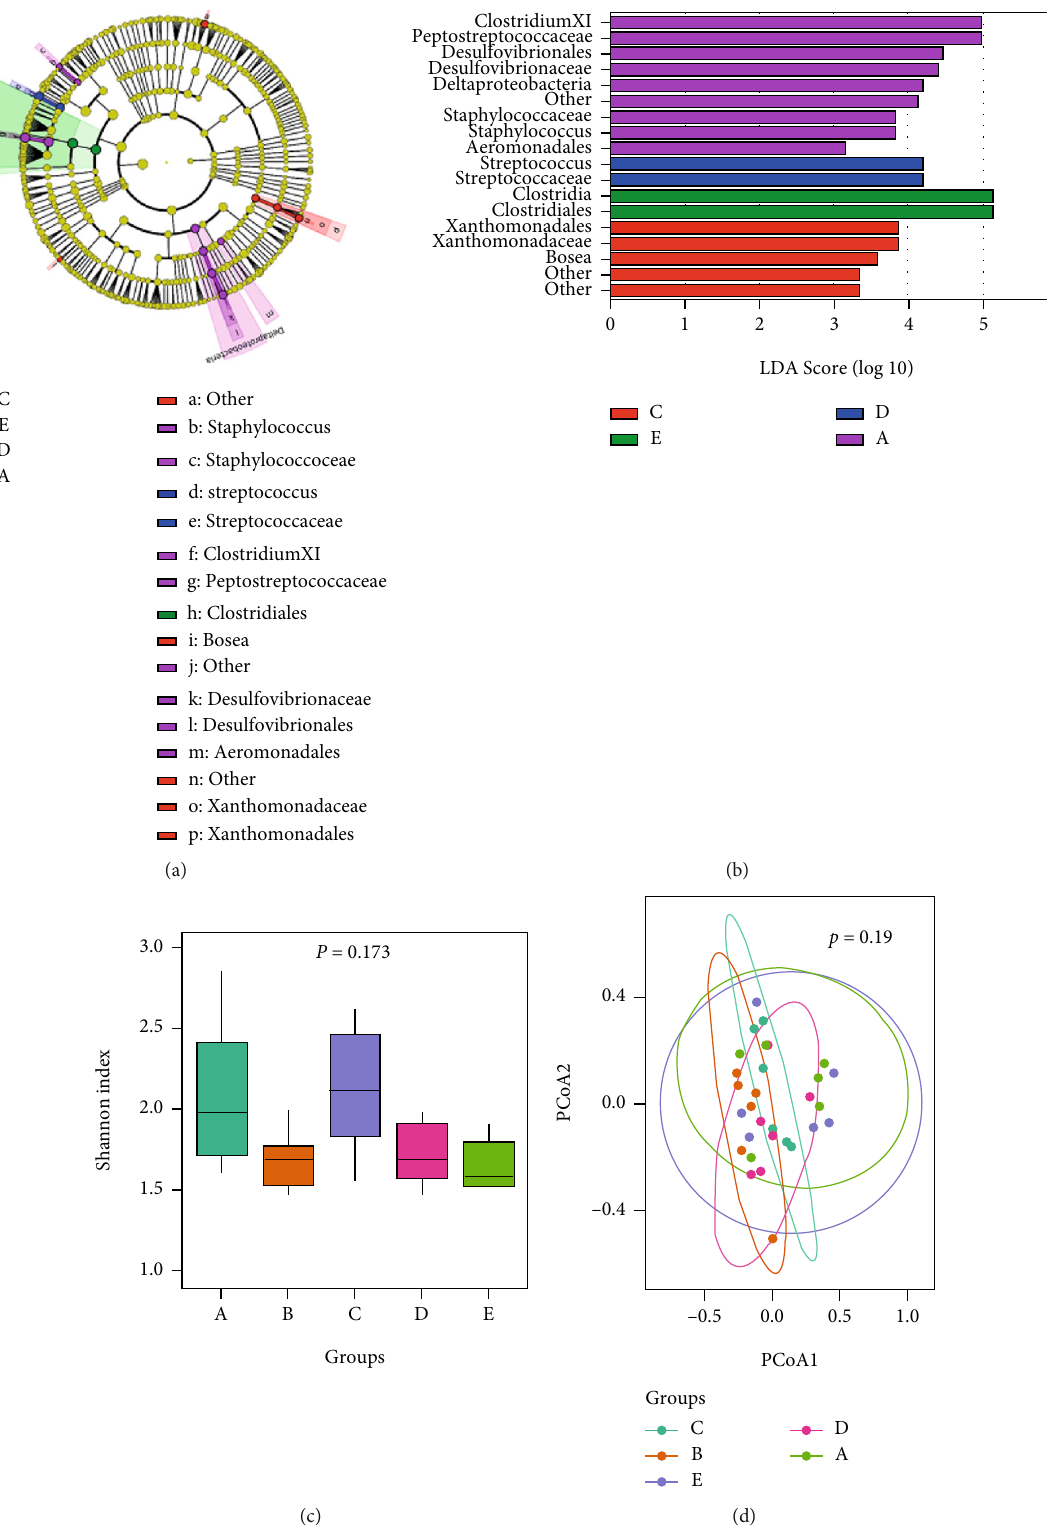
Figure 2: E ff ects of Bacillus subtilis PB6 on intestinal bacterial diversity in broilers challenged with Clostridium perfringens . (a) Diversity and composition of ileal microbiota (LEfSe score) in broilers. (b) Diversity and composition of ileal microbiota (circular cladogram) in broilers. (c) Alpha diversity analysis (Shannon) of ileal microbiota in broilers. (d) Beta diversity analysis (PCoA) of ileal microbiota in broilers. Treatment information: A: basal diet; B: basal diet and CP challenge; C: CP challenge+10mg/kg enramycin (positive control group); D: CP challenge+ 4 × 10 7 CFU/kg of feed B . subtilis PB6 (PB6 low-dosage group); E: CP challenge+ 6 × 10 7 CFU/kg of feed B . subtilis PB6 (PB6 high-dosage